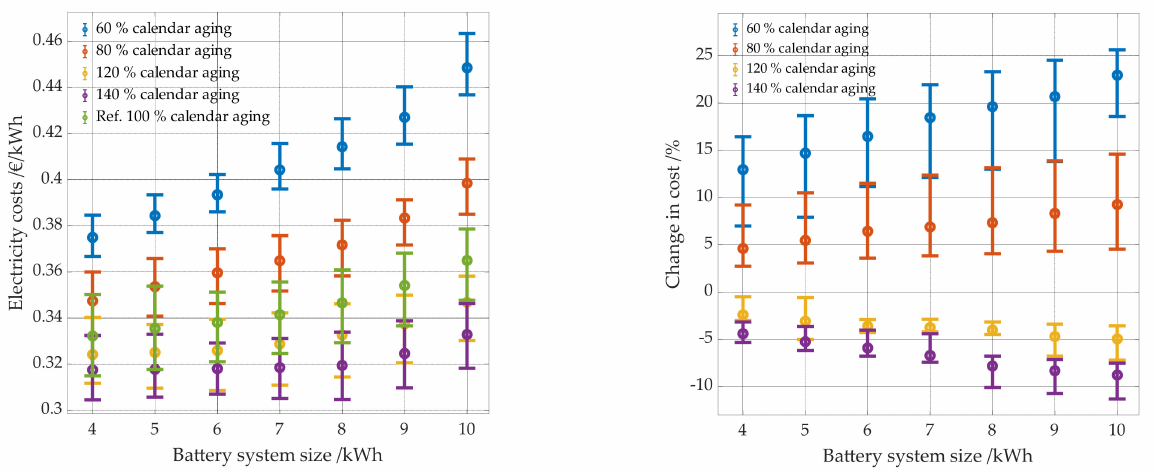
Figure 23. Electricity costs per kWh as a function of battery system size ( left panel) and the change in cost as a function of battery size ( right panel). The results for different degrees of calendrical aging are shown in color. The reference case is shown in green.